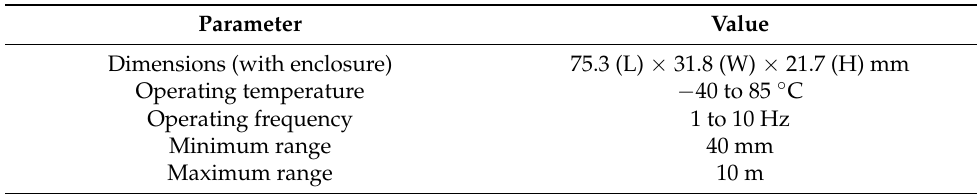
Table 2. Sonar Phidget DST1200_0 sensor specifications (based on information from [44]).